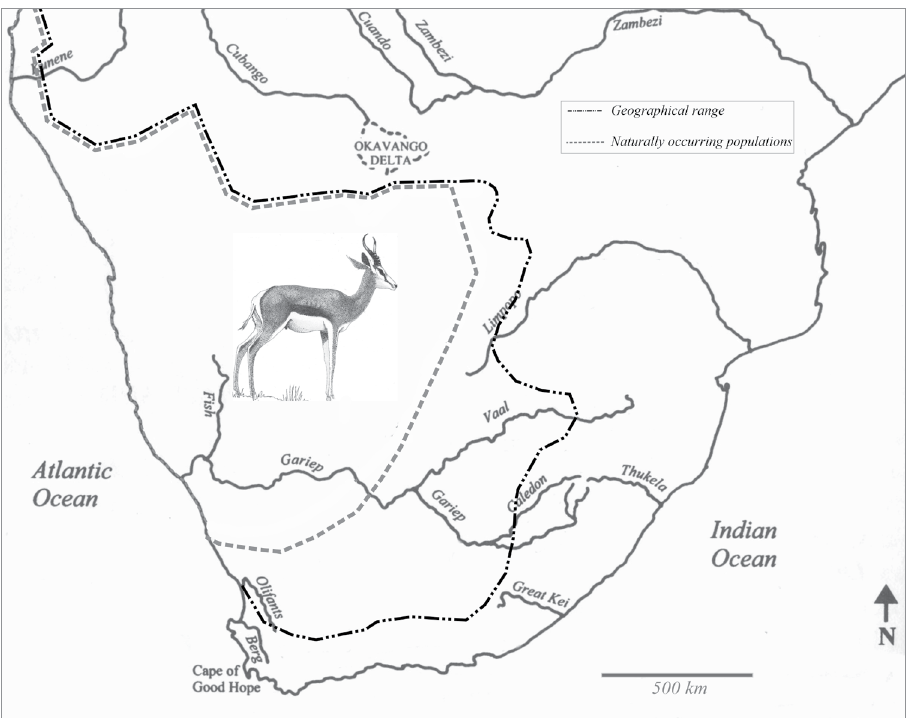
Figure 1: Present-day geographical range and present-day range of naturally occurring populations of Antidorcas marsupialis according to Smithers 2 and Skinner and Louw 3 .